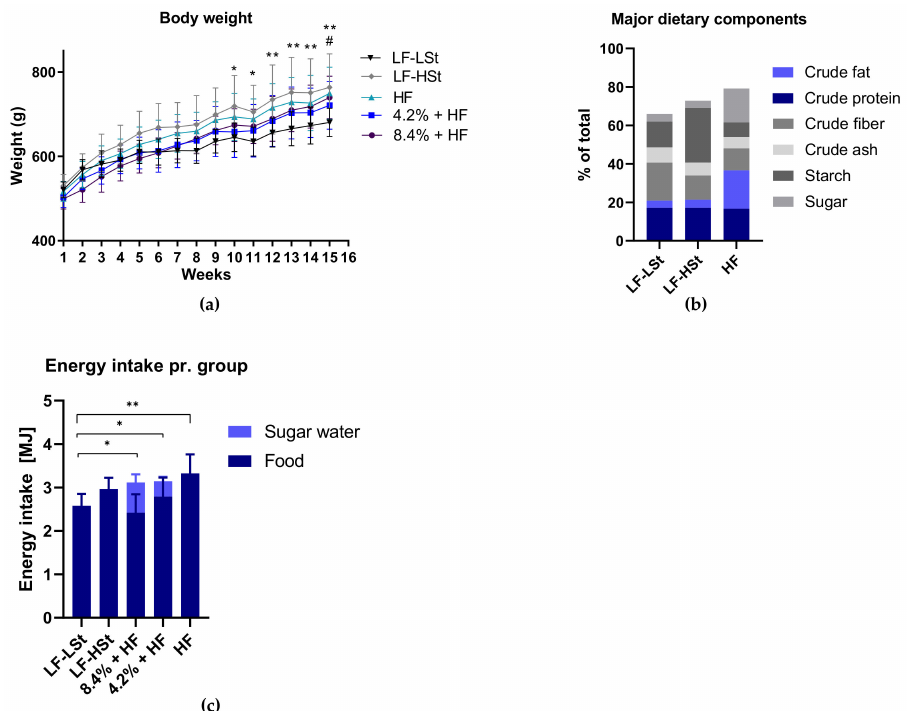
Figure 1. Body Weight and Energy Intake. ( a ) Body weights for each group are presented as means with SD, for each week. Data was analyzed using a mixed effects model with repeated measures with a Tukey’s test for multiple comparisons. n = 8 ( b ) Major dietary components presented in % ( c ) Energy intake in MJ for each group is presented as means with SD and analyzed using a one-way ANOVA with a Dunnett’s test for multiple comparisons. n = 13 average weekly intake pr. group during the study period. For LF-LSt vs. LF-HSt * p < 0.05, ** p < 0.01. for LF-LSt vs. HF # p < 0.05.